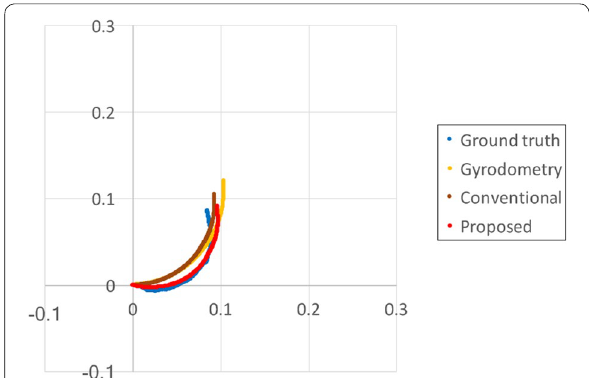
Fig. 16 Result of position estimation: slope angle is 8 ◦ , input velocity is 5 cm/s, and input angular velocity is 30 ◦